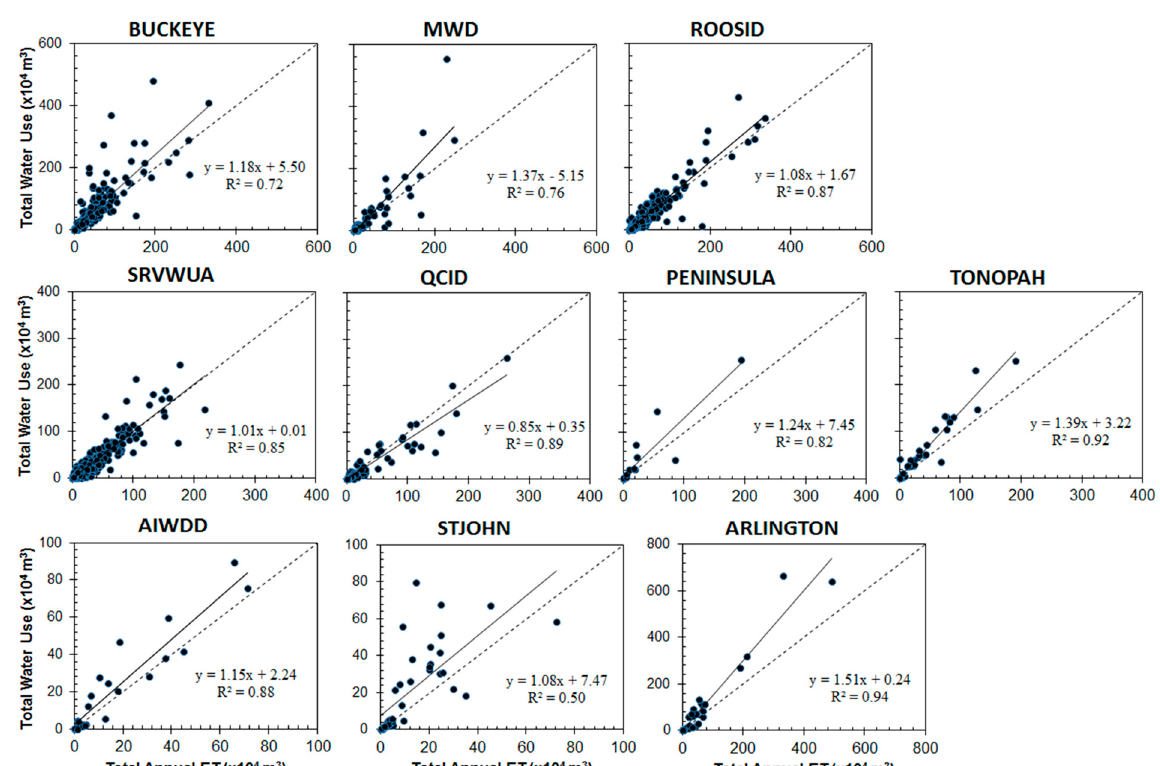
Figure 6. Comparison between total annual ET and total water use. The analysis was performed at the farm unit level for each irrigation district.